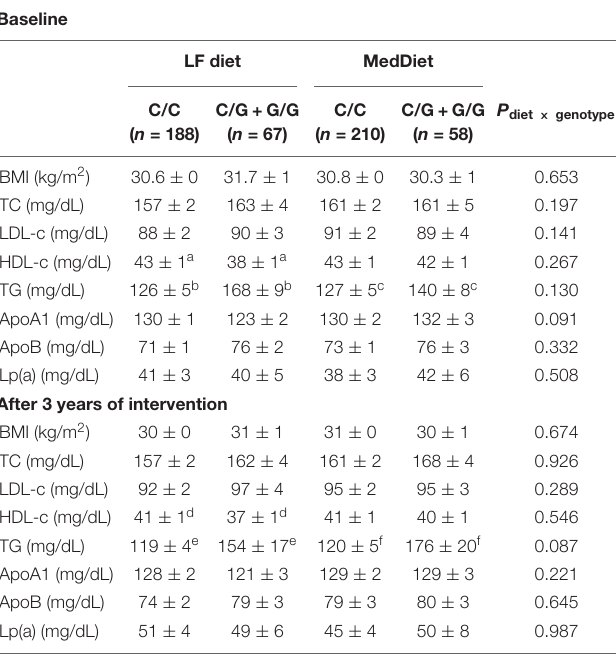
Values expressed as mean ± SEM. P-values were calculated using the ANOVA test adjusted by age, gender, BMI, statins, and fibrates. ApoA, apolipoprotein A; ApoB, apolipoprotein B; BMI, body mass index; HDL-c, high-density lipoprotein cholesterol; LDL-c, low-density lipoprotein cholesterol; LF, low-fat; Lp(a), lipoprotein a; TC, total cholesterol; TG, triglycerides. Equal superscript letters indicate statistical differences with p-values < 0.05 between